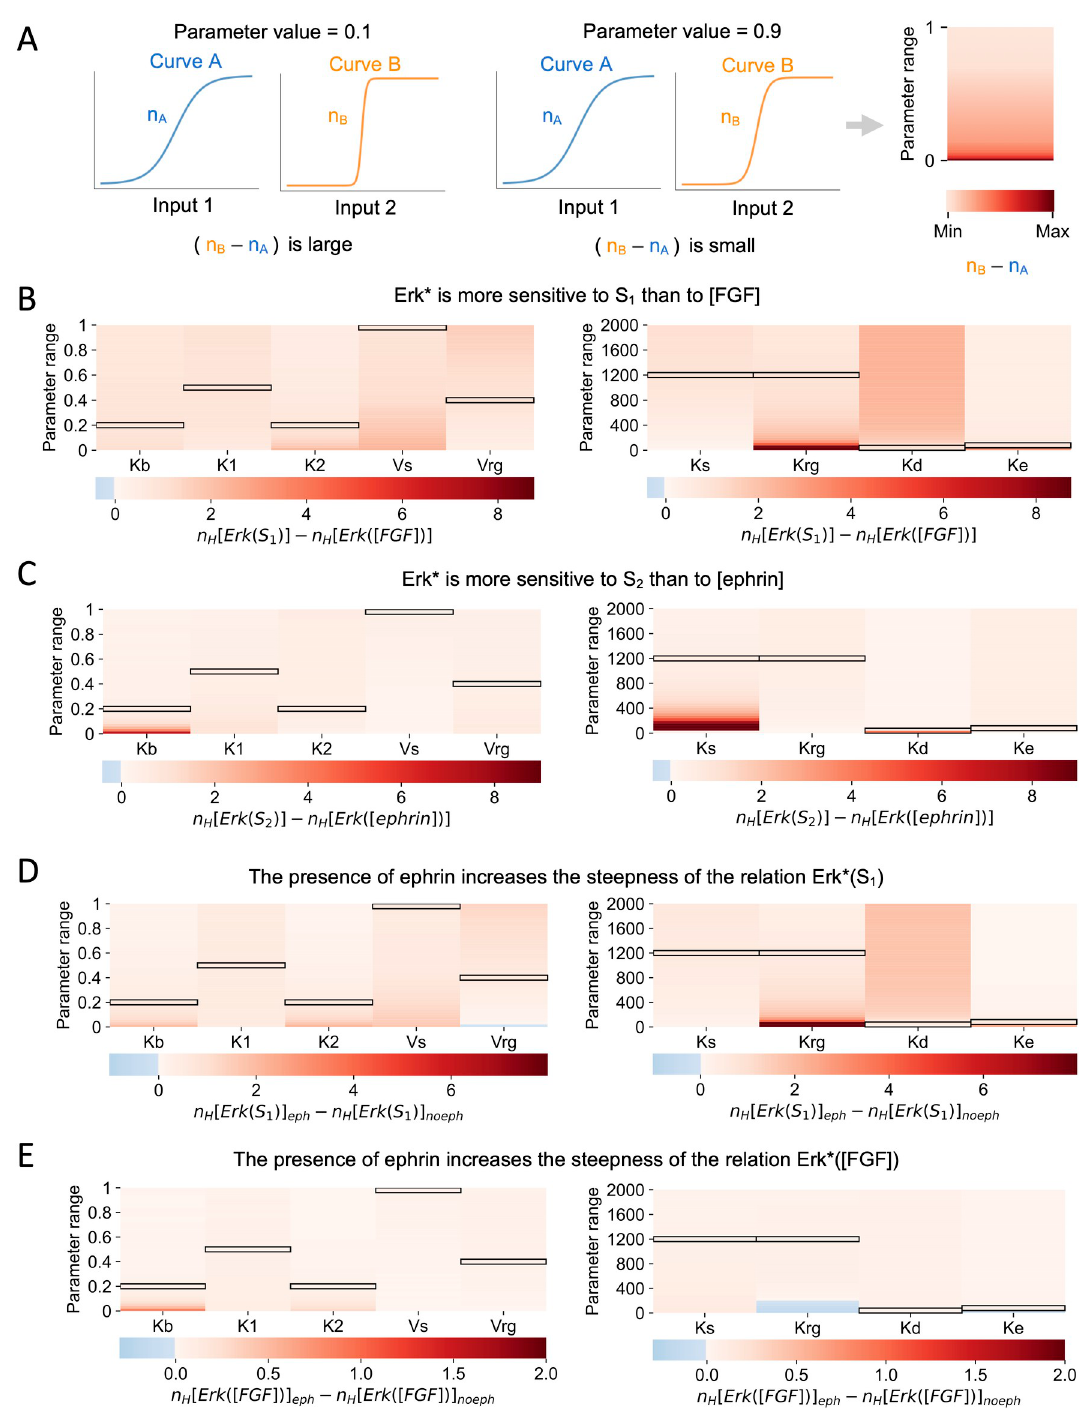
Fig 5. Model predictions related to the factors affecting Erk activity. (A) Graphical explanation of the numerical procedure. We consider two generic curves A and B with Hill coefficients n A and n B respectively. The shape of both curves depends on the value of a parameter p that can range from 0 to 1. On the left, the curves A and B are shown when the value of the parameter p is equal to 0.1. In this condition the difference of the two Hill coefficient n B -n A is large. In the middle, the curves A and B are shown when the value of the parameter p is equal to 0.9. In this condition the difference of the two Hill coefficient n B -n A is smaller. The right panel is the heatmap showing the differences between the Hill coefficients of curves A and B (n B -n A ) computed for all values of p between 0 and 1. (B) Erk � values are more sensitive to S 1 than to [FGF]. Heatmaps show the difference between the Hill coefficient of the curve Erk � (S 1